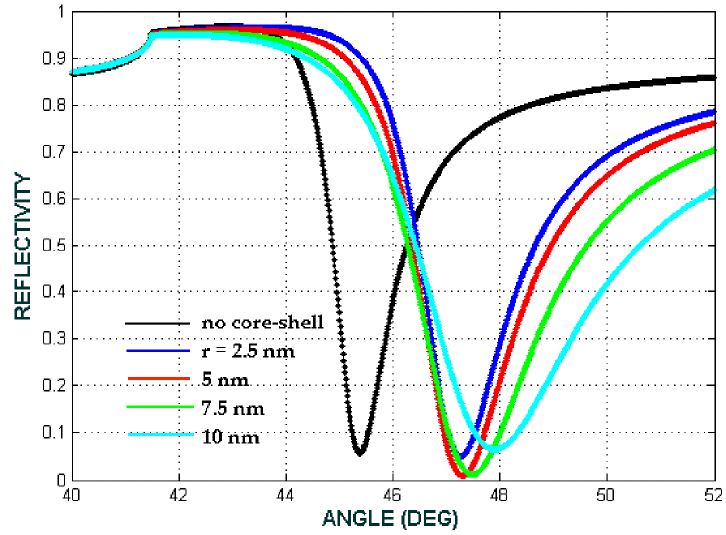
Figure 12. The ATR spectra for the volume fraction of the composite F = 0.8. The radius of the core-shell varied from 2.5 nm to 10 nm with a fixed ( b / a ) 3 = 0.73 (biomaterial sample is Hb cytoplasma with a refractive index of 1.3871 or the concentration 12.93 mmol L − 1 ). In this presented model, biomaterial samples are blood plasma, Hb cytoplasm and lecithin with RIs of 1.3479, 1.3800 and 1.4838, respectively. Figure 13, Figure 14 and Figure 15 show the comparison of the angular shift of the SPR angle for three different configuration respectively.